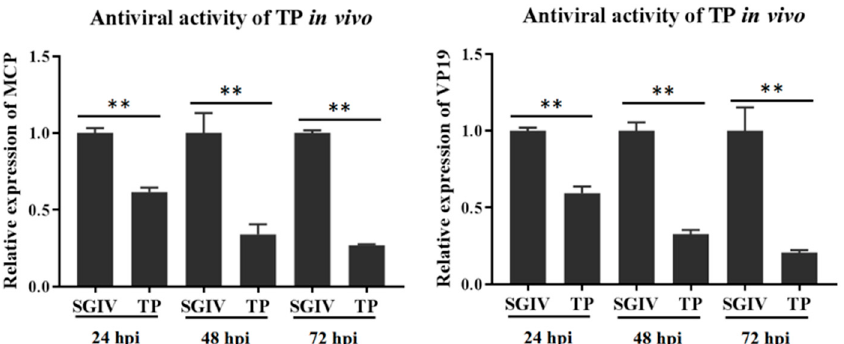
Figure 8. Antiviral activity of green tea component TP against SGIV in vivo. Hybrid groupers were injected intraperitoneally with SGIV mixed with TP at its safe working concentration of 10 µ g/mL. Spleen tissues were analyzed for antiviral activity at 24, 48, and 72 hpi. ** indicates p < 0.01.